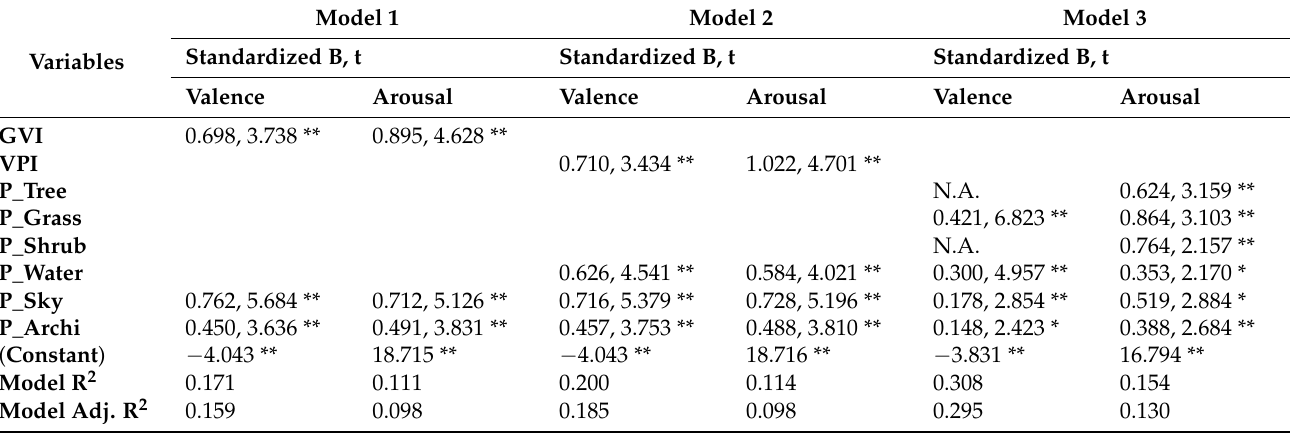
Table 5. Results of backwards stepwise regression analysis on the relationship between visual variables and emotional data.